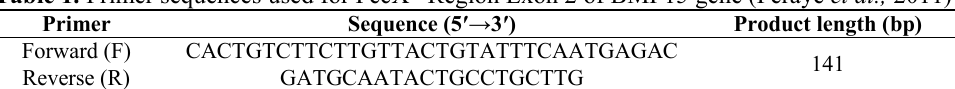
Table 1. Primer sequences used for FecX G Region Exon 2 of BMP15 gene (Feraye et al., 2011) Primer Sequence